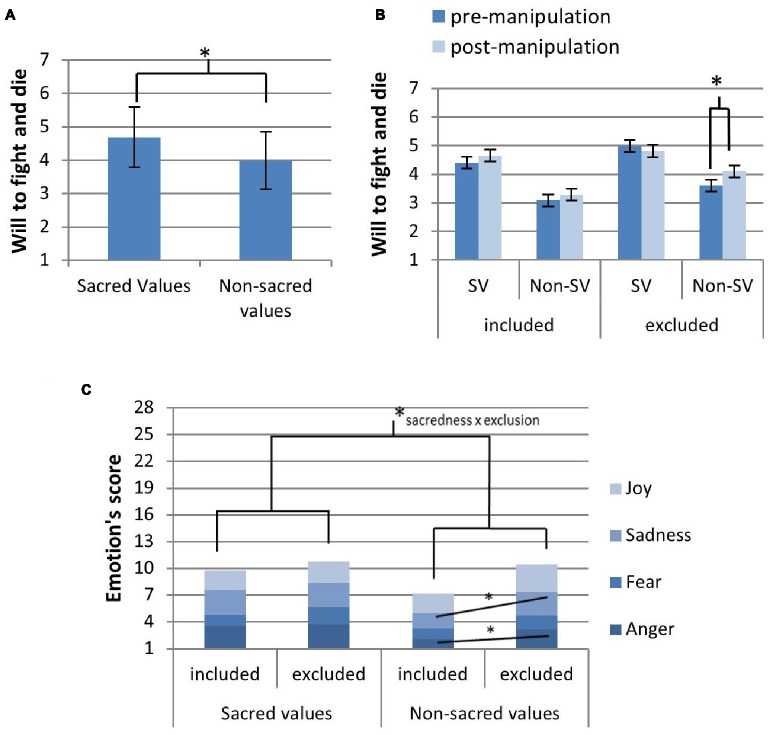
Behavioral analysis results including: (A) higher premanipulation will to fight and die for sacred versus nonsacred values (t(37) = 10.831, p < 0.001, and Cohen’s d = 0.80), (B) an increase in will to fight and die for nonsacred versus sacred values in excluded participants compared to nonexcluded participants after the experimental manipulation (Wilks’ λ = 0.852, F(1,35) = 6.077, p = 0.019, and η
2
p = 0.148), and (C) higher emotional intensity ratings (out of 28 possible points) at the thought of defending sacred versus nonsacred values (t(36) = 2.59, p = 0.014, and Cohen’s d = 0.40) and higher emotional intensity ratings for nonsacred values versus sacred values in the social exclusion versus inclusion condition (Wilks’ λ = 0.848, F(1,35) = 6.26, p = 0.017, η
2
p = 0.152), driven by sadness (Wilks’ λ = 0.834, F(1,35) = 6.99, p = 0.012, and η
2
p = 0.166) and anger (Wilks’ λ = 0.888, F(1,35) = 4.43, p = 0.043, and η
2
p = 0.112).